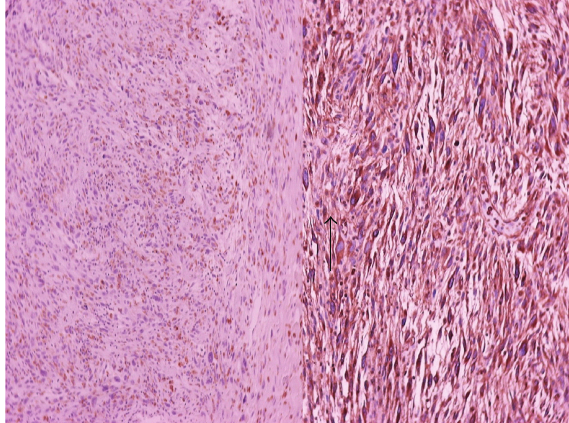
Figure 5: Immunohistochemistry with vimentin (left) and CD 68/100